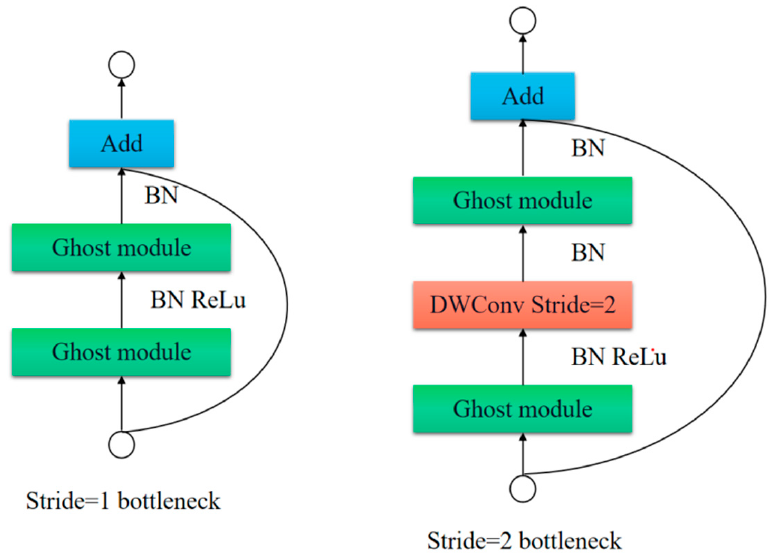
Figure 3. Ghost Bottleneck.